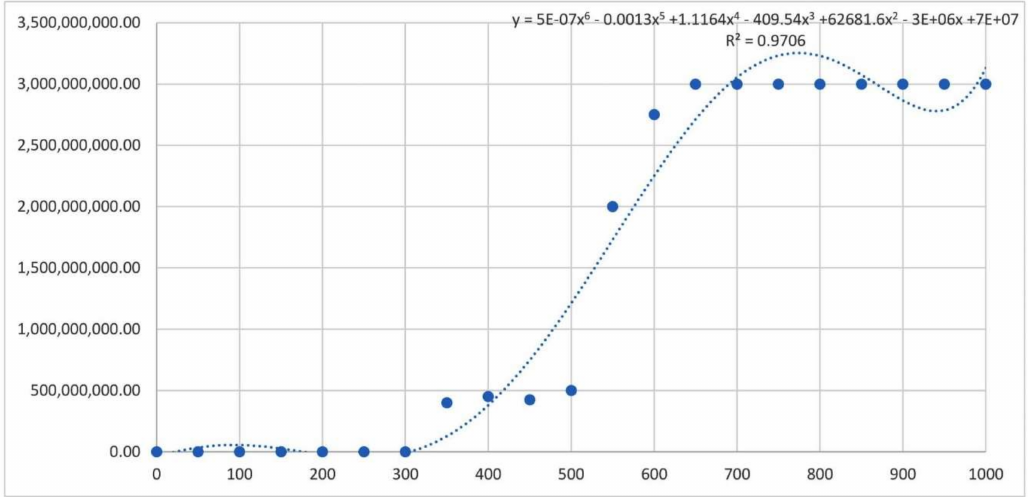
Figure 4. Economic loss